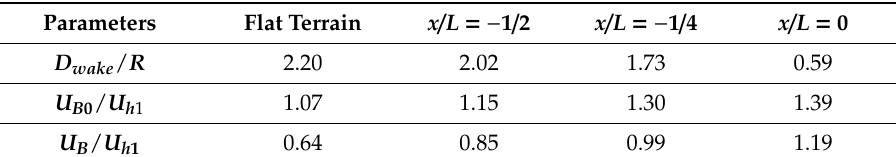
Table 4. Parameters used for the calculations.